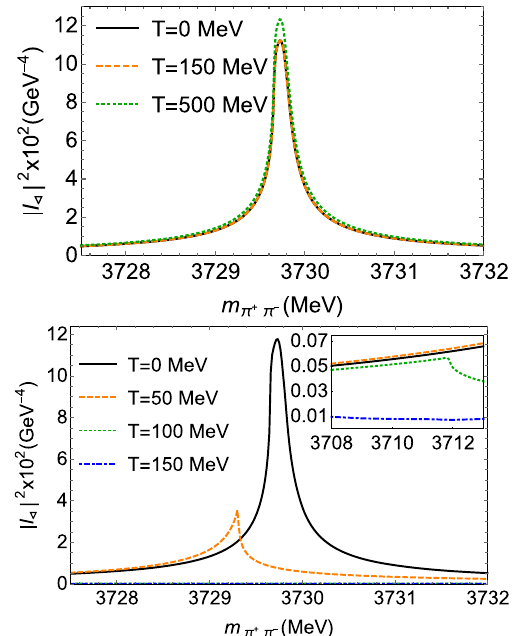
Fig. 7 Squared modulus of triangle loop integral ( | I (cid:4) | 2 ) in Eq. (6) for the reaction (14) as function of m pn at finite T , with intermediate particles 1, 2 and 3 being Δ + , p , n respectively. The invariant mass of Δ + p is fixed at 2188.68 MeV. Top: masses and widths taken at their vacuum values [24] except for a regulating Γ 2 = 0 . 5 MeV to avoid numerical instability. Bottom: the (small) thermal corrections to the ( 1 , 2 , 3 ) meson masses and widths are included, according to the values shown in Table